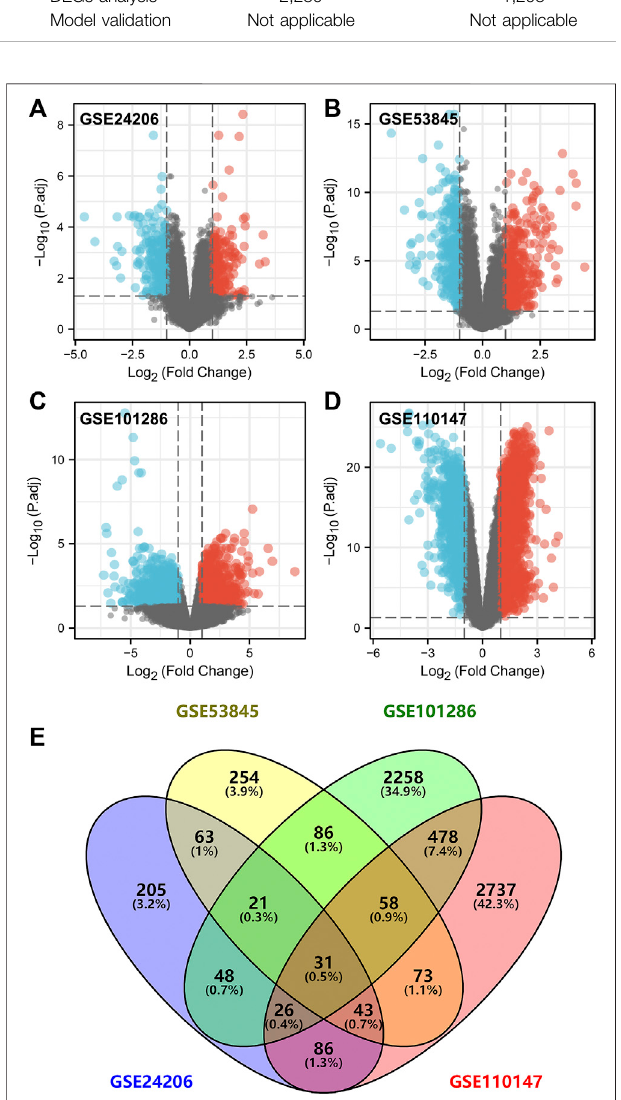
FIGURE 1 | Identi fi cation of DEGs in IPF patients. Notes: (A – D) : DEGs analysis was performed between IPF and normal lung tissue with the threshold of p < 0.05 and |logFC| > 1 based on the GSE24206, GSE53845, GSE101286andGSE110147; (E) :AVenngraphanalysisintersected31 common DEGs in GSE24206, GSE53845, GSE101286 and GSE110147